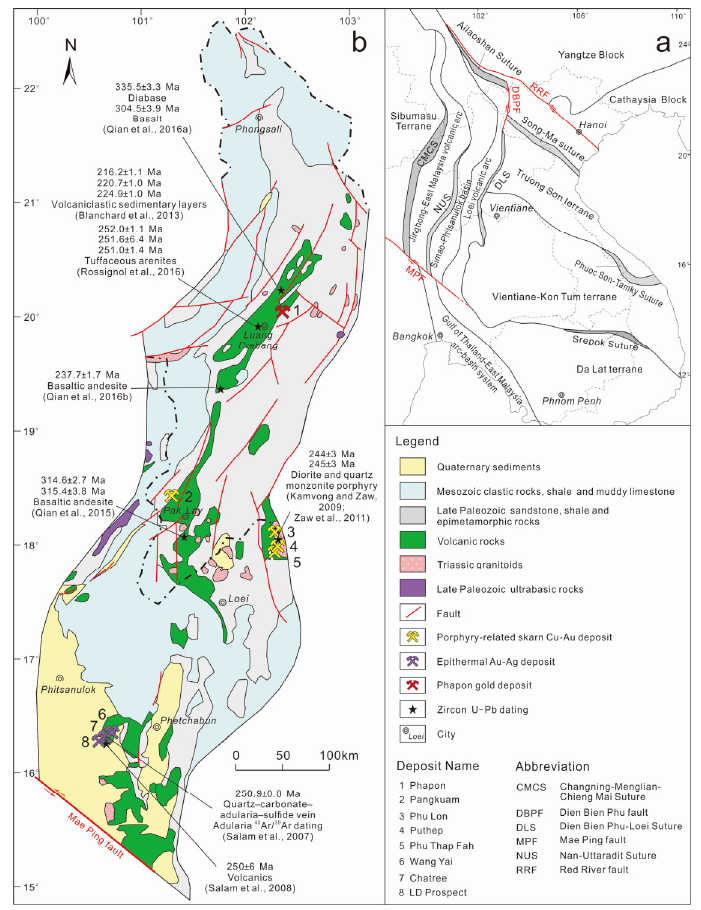
Figure 1. Regional geological map. ( a ) Simplified tectonic map showing structural units of Laos and adjacent regions [4,16]; ( b ) Simplified geological map of the Luang Prabang–Loei metallogenic belt (modified from [5]). RRF, Red River fault; DBPF, Dien Bien Phu fault; MPF, Mae Ping fault; CMCS, Changning-Menglian-Chieng Mai Suture; NUS, Nan-Uttaradit Suture; DLS, Dien Bien Phu-Loei Suture.